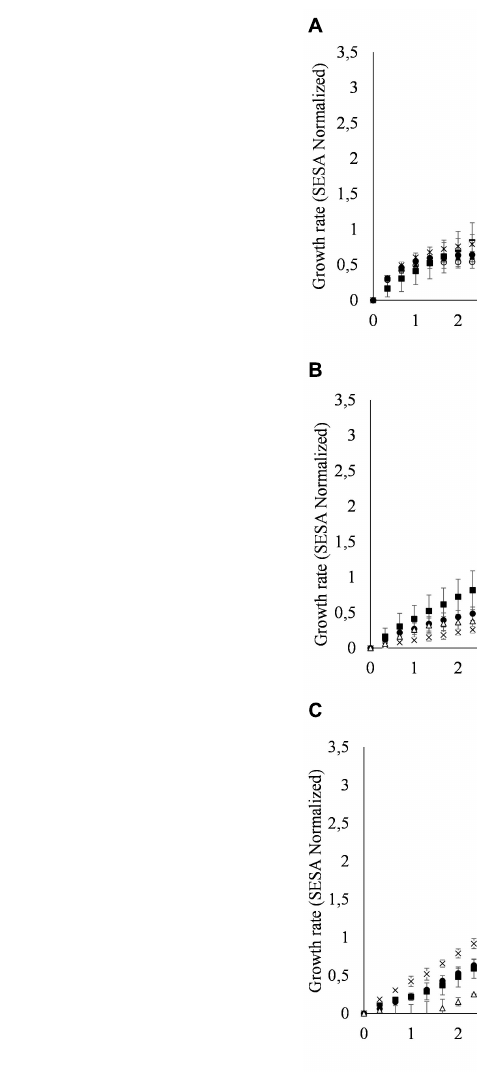
FIGURE 5 | Culture assays measuring the growth of S. aureus CC-type 1 when exposed to cell-free supernatants from Lactiplantibacillus plantarum subsp. plantarum LB224R. Growth over time assessed by the oCelloscope using the normalized segmentation and extraction of surface area (SESA) algorithm. (A) S. aureus CC-type 1 growth inhibition by CFS from the LAB strains selected in the tertiary screen (B) Broth microdilution determination of S. aureus CC-type 1 growth inhibition by percentages of added LB244R CFS. (C) Determination of pH effect on antibacterial activity of CFS. S. aureus CC-type 1 is cultured with pH neutralized LB244R CFS (pH 6). The values are the mean ± standard deviations of triplicates repeated in two individual